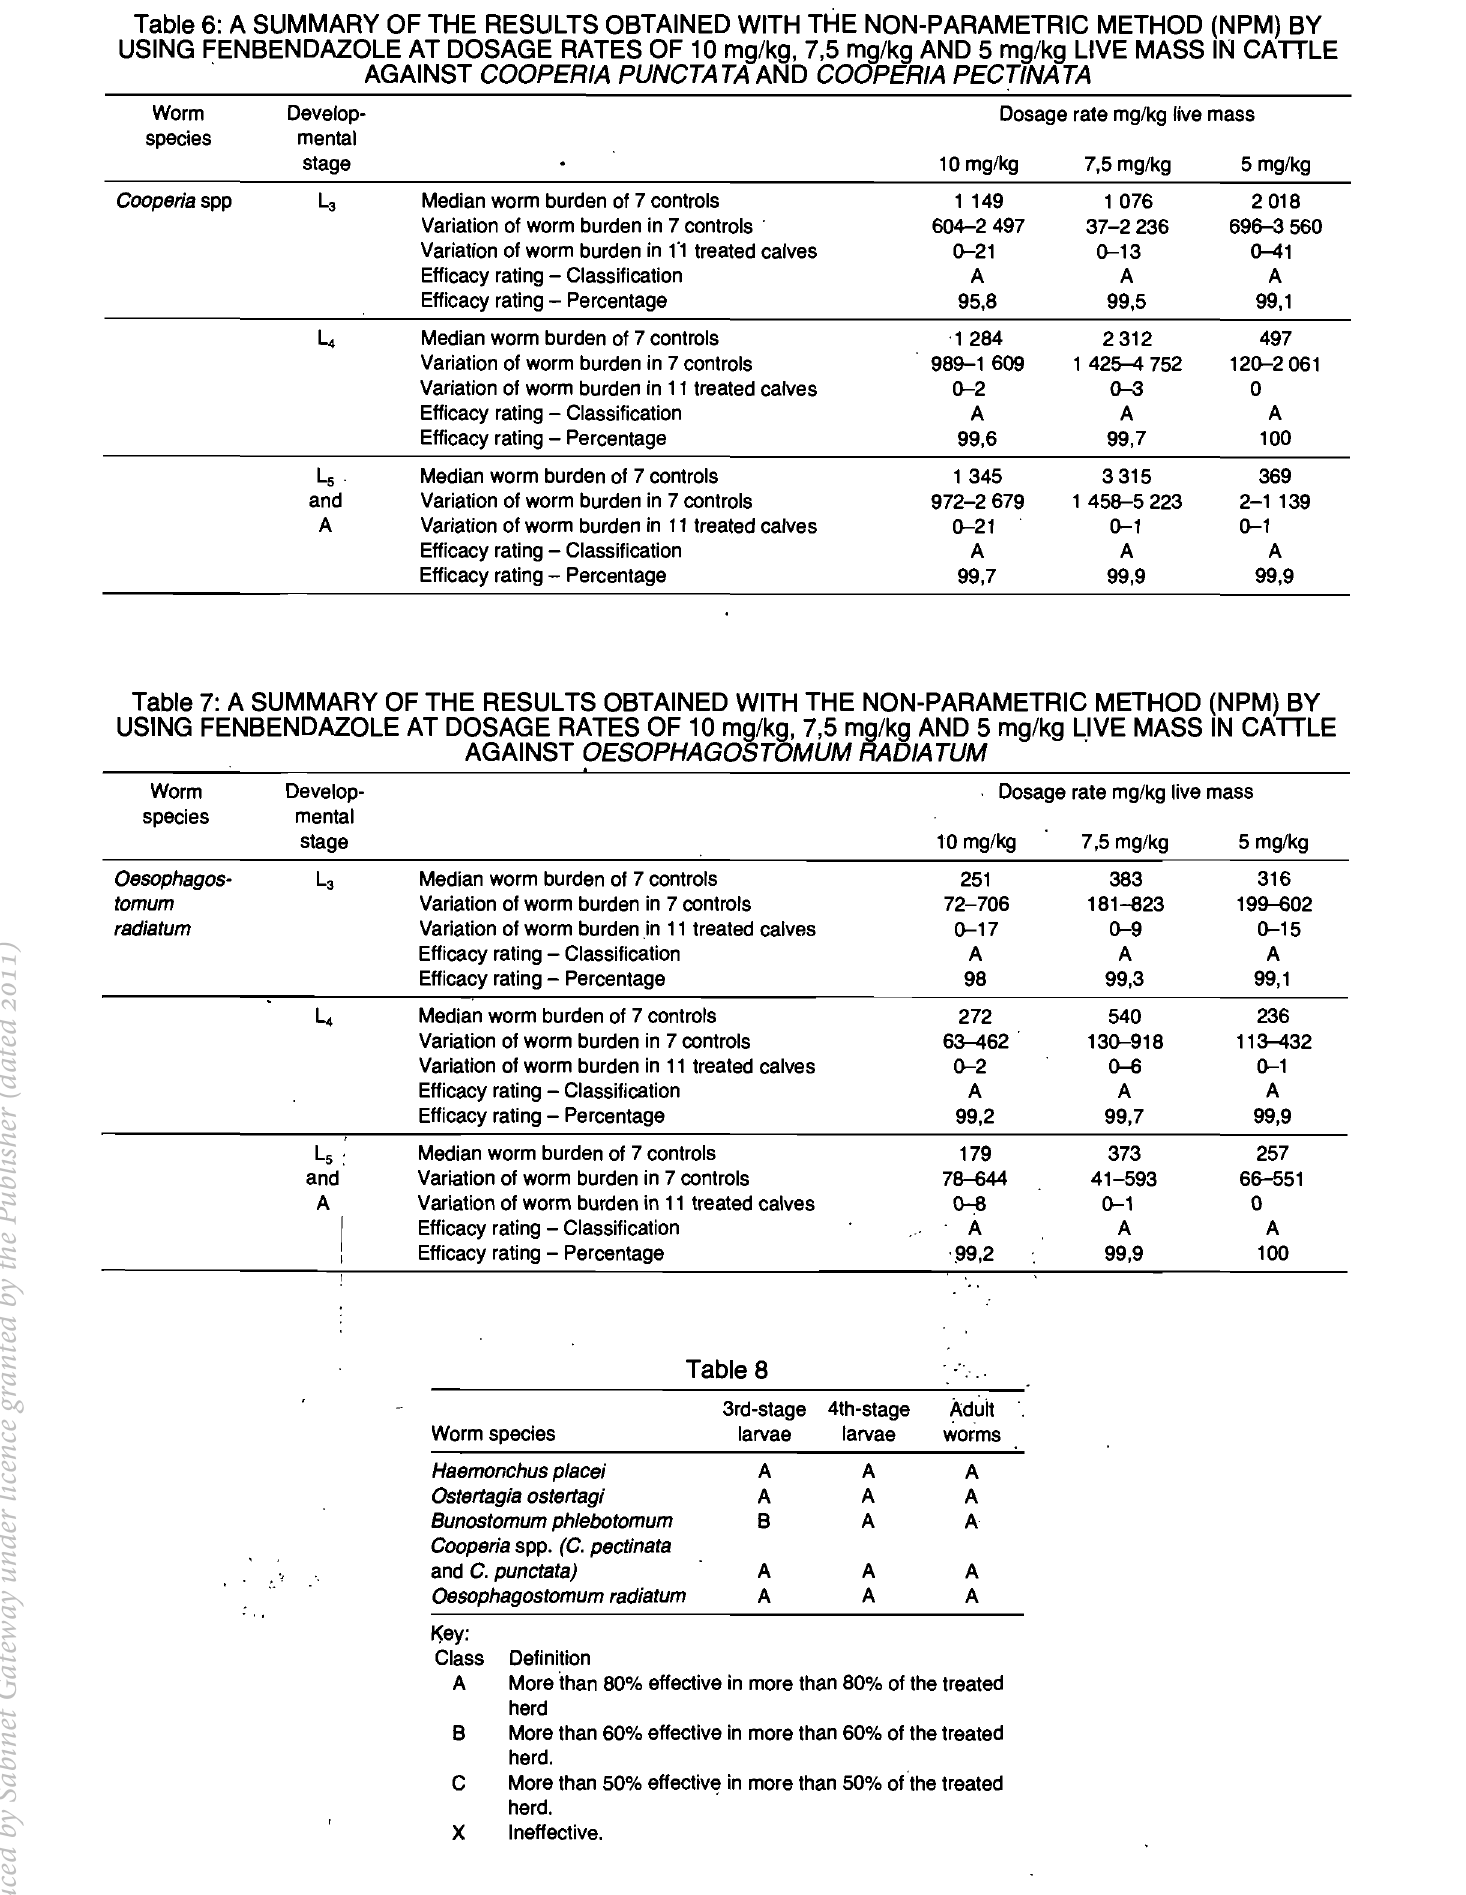
Table 6: A SUMMARY OF THE RESULTS OBTAINED WITH THE NON-PARAMETRIC METHOD (NPM) BY USING FENBENDAZOLE AT DOSAGE RATES OF 10 mg/kg, 7,5 mg/kg AND 5 mg/kg LIVE MASS IN CATTLE AGAINST COOPERIA PUNCTATA AND COOPERIA PECTINATA